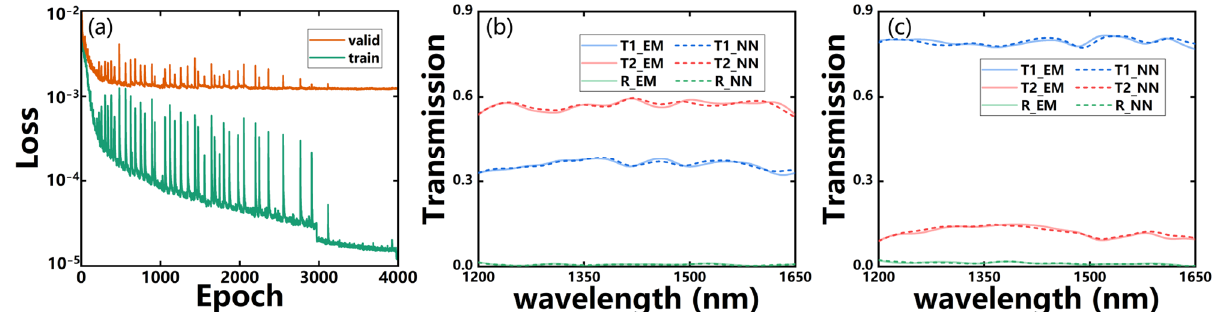
Figure 4. ( a ) The loss evolution during training (green line) and validation (orange line) processes of the sim-NN. ( b , c ) Comparisons of the transmission spectra from the EM (solid line) and sim-NN predictions (dashed line) for the two randomly selected MMI splitters from the validation set.